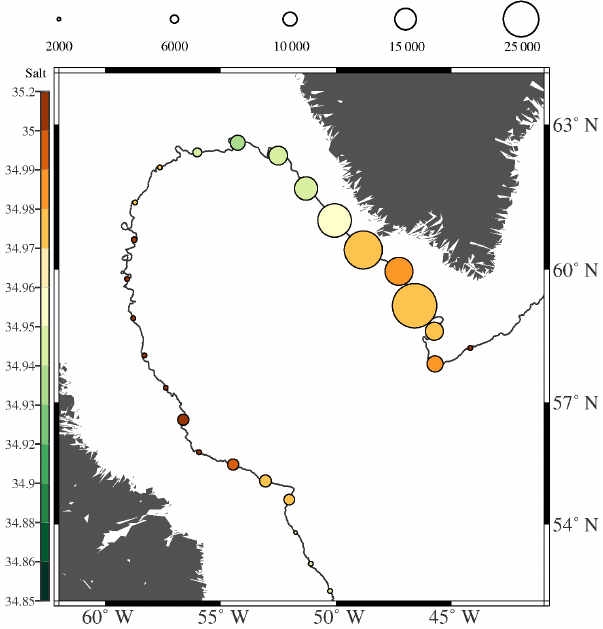
Figure 4. The probability of crossings per 100km along the bound- ary is indicated by the size of the circles, with larger circles indi- cating a larger probability. The color shows the mean salinity of the crossings at each